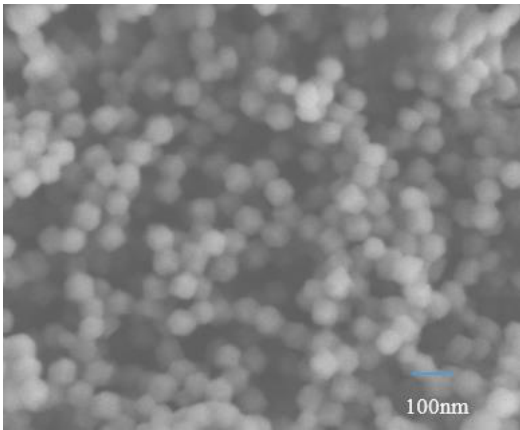
Figure 4. The SEM images of ZIF-8. Figure 5 analyzes the thermal stability of the synthesized ZIF-8 in the temperature range from room temperature to 800 ◦ C. In the range of room temperature to 500 ◦ C, the material of ZIF-8 has a slight weight loss, which is probably caused by the dehydration of the skeleton in ZIF-8. When the temperature reaches approximately 600 ◦ C, ZIF-8 appears to have an obvious weight loss phenomenon, and the rate of mass decline is obviously accelerated. This is due to the decomposition of ZIF-8 particles. After the complete decomposition of ZIF-8, the solid remains of ZnO are left. ZIF-8 nanoparticles exhibit an excellent thermal stability, which is attributed to the presence of coordination bonds [44]. Through analysis, it can be concluded that the thermal stability temperature of synthesized ZIF-8 in the experiment is 600 ◦ C, which is consistent with previous reports in the literature